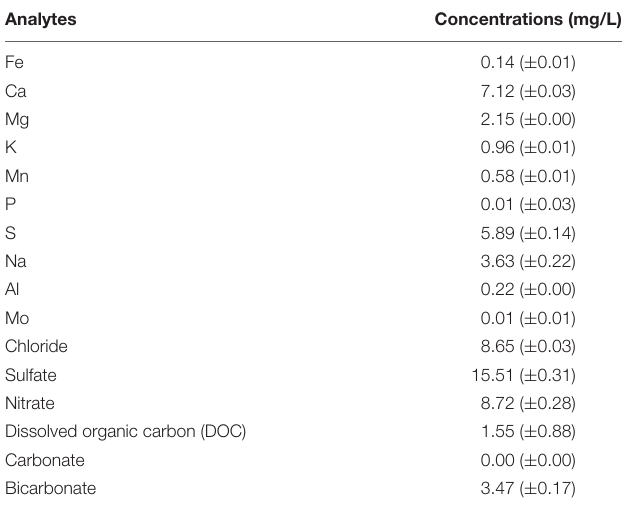
TABLE 1 | Bulk geochemical analyses of the spring water sample collected in June 2017. Data are means ± standard error